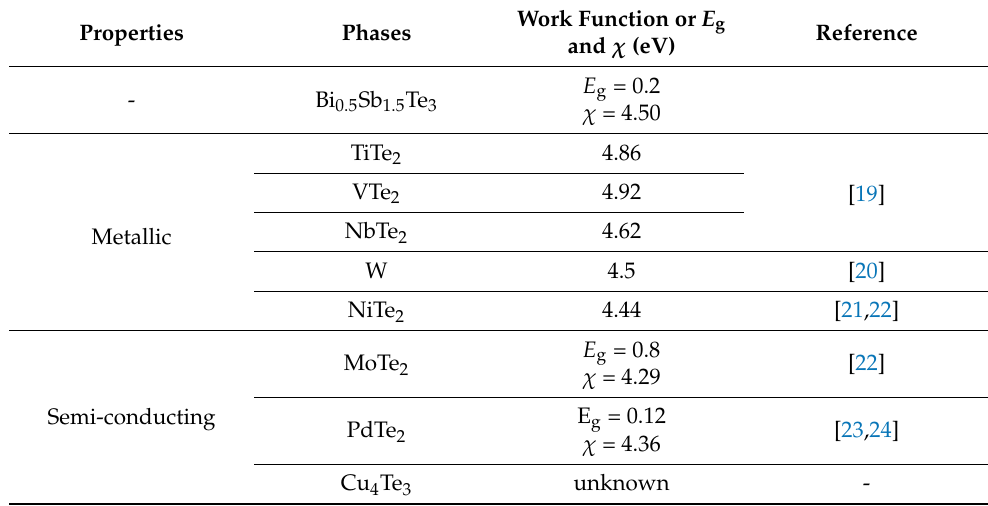
Table 1. Work functions or band gap ( E g ) and electron affinity ( χ ) of the precipitates. Properties Phases